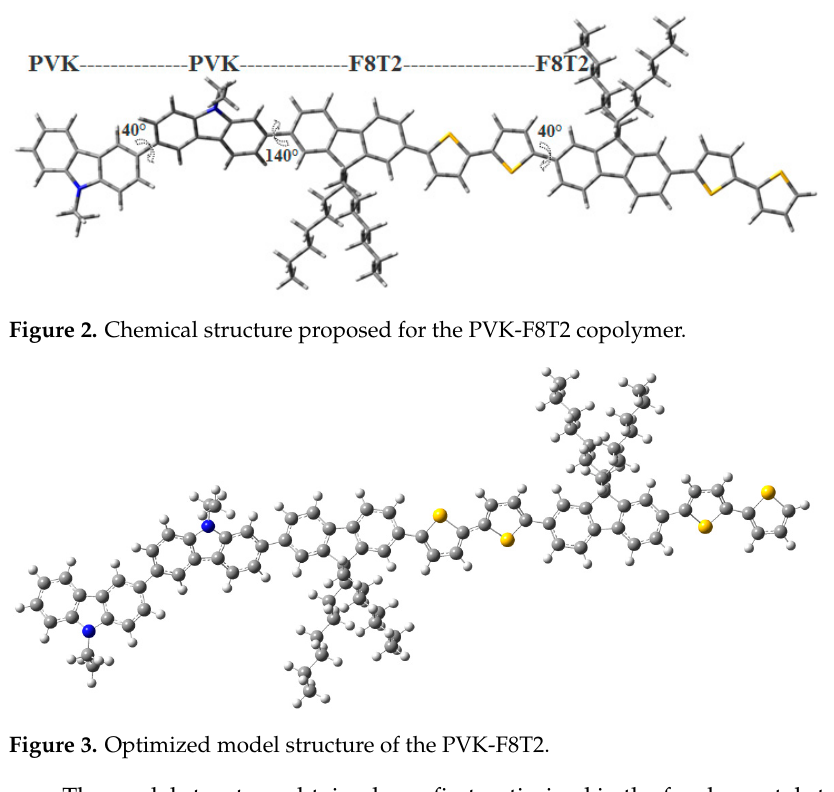
Figure 2. Chemical structure proposed for the PVK-F8T2 copolymer.